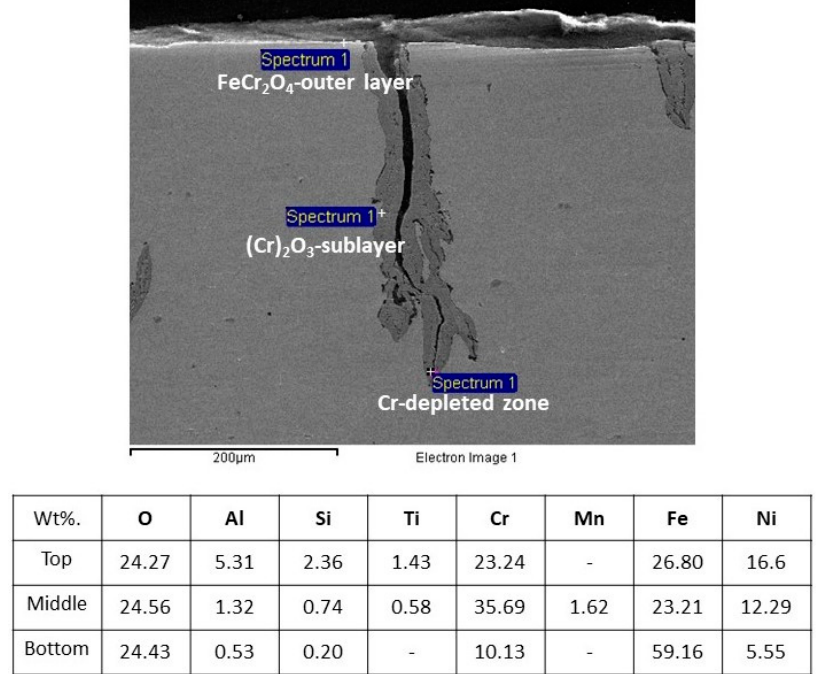
Figure 15. Typical surface ‐ connected grain boundaries (GBs) oxide crack for BM specimen. LCF ‐ HT test at 0.6% total strain range.